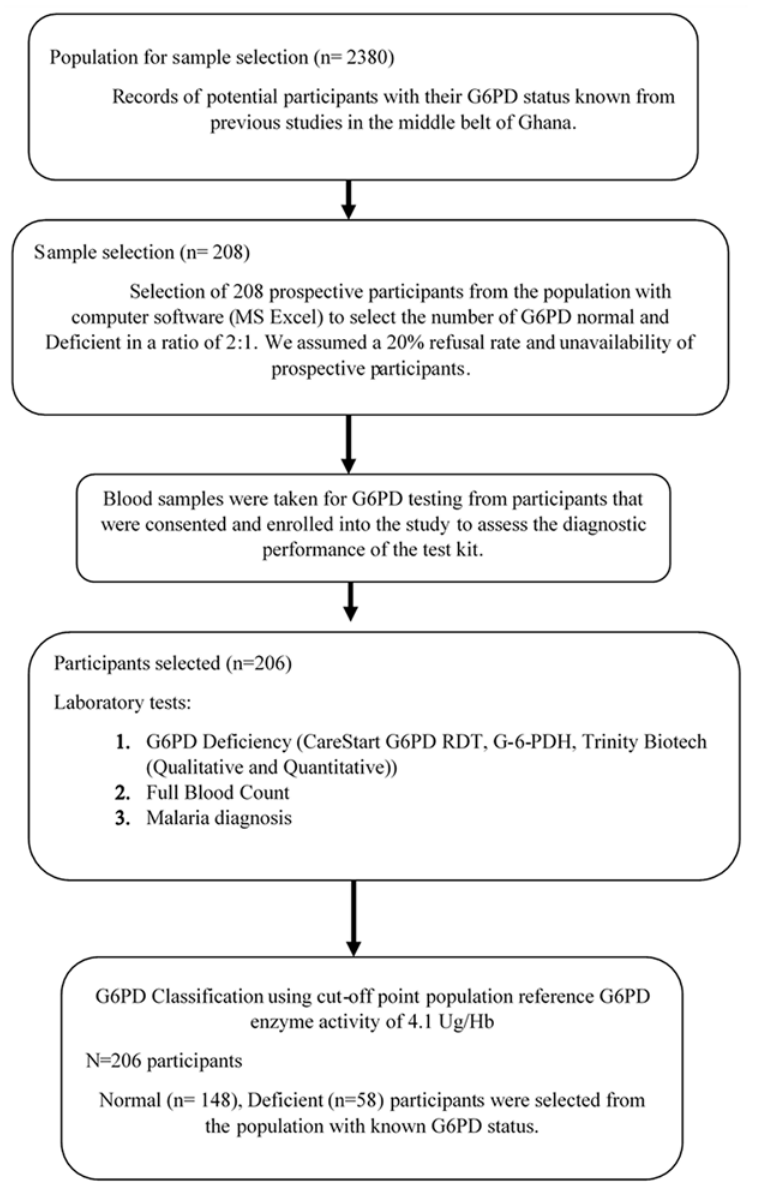
Fig 2. Flow chart of profile for study participants ’ selection and